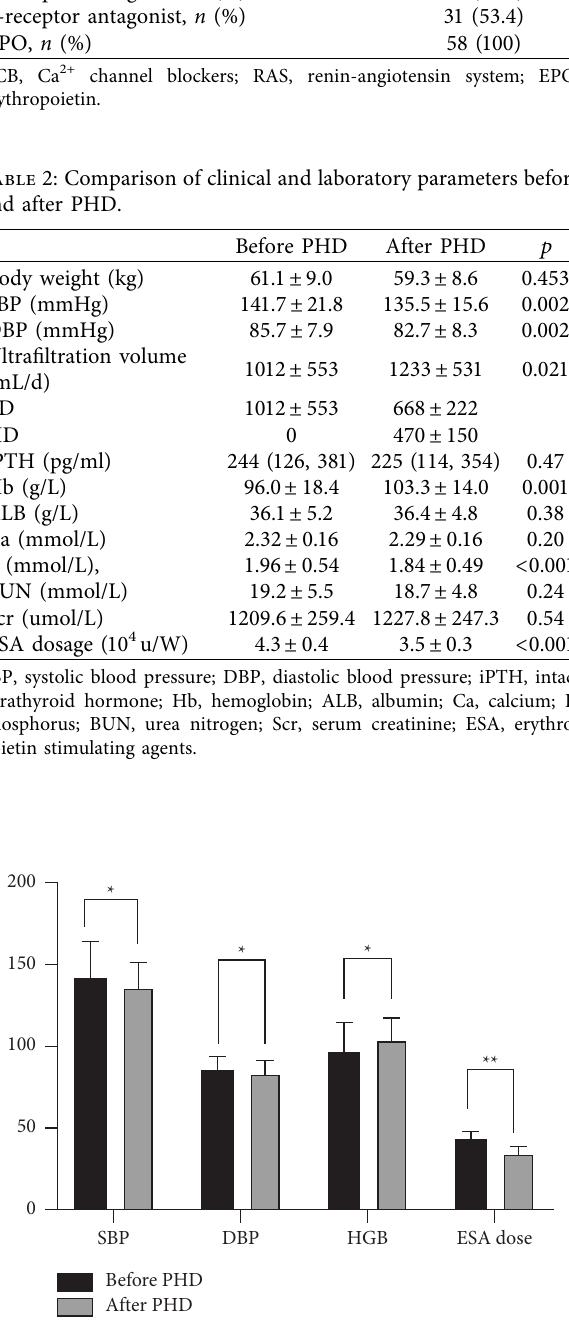
Figure 2: Comparison of SBP, DBP, hemoglobin, and ESA